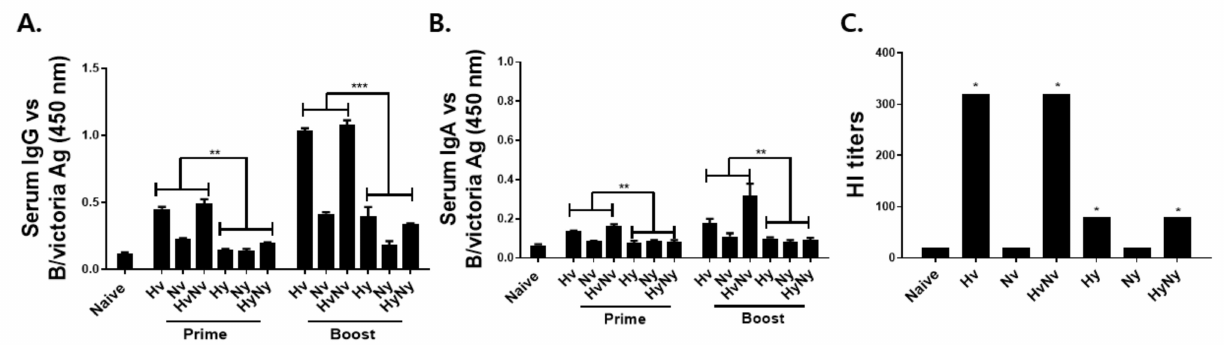
Figure 2. Antibody responses and hemagglutinin inhibition in sera. BALB/c mice ( n = 8 per group) were intramuscularly immunized with VLPs vaccines and sera were collected at regular intervals after each immunization. B/Colorado/06/2017 virus-specific IgG ( A ) and IgA ( B ) antibody responses, as well as HI titers ( C ), were determined. Data are expressed as mean ± SD with asterisks denoting statistical significance between groups (* p < 0.05, ** p < 0.01, *** p <